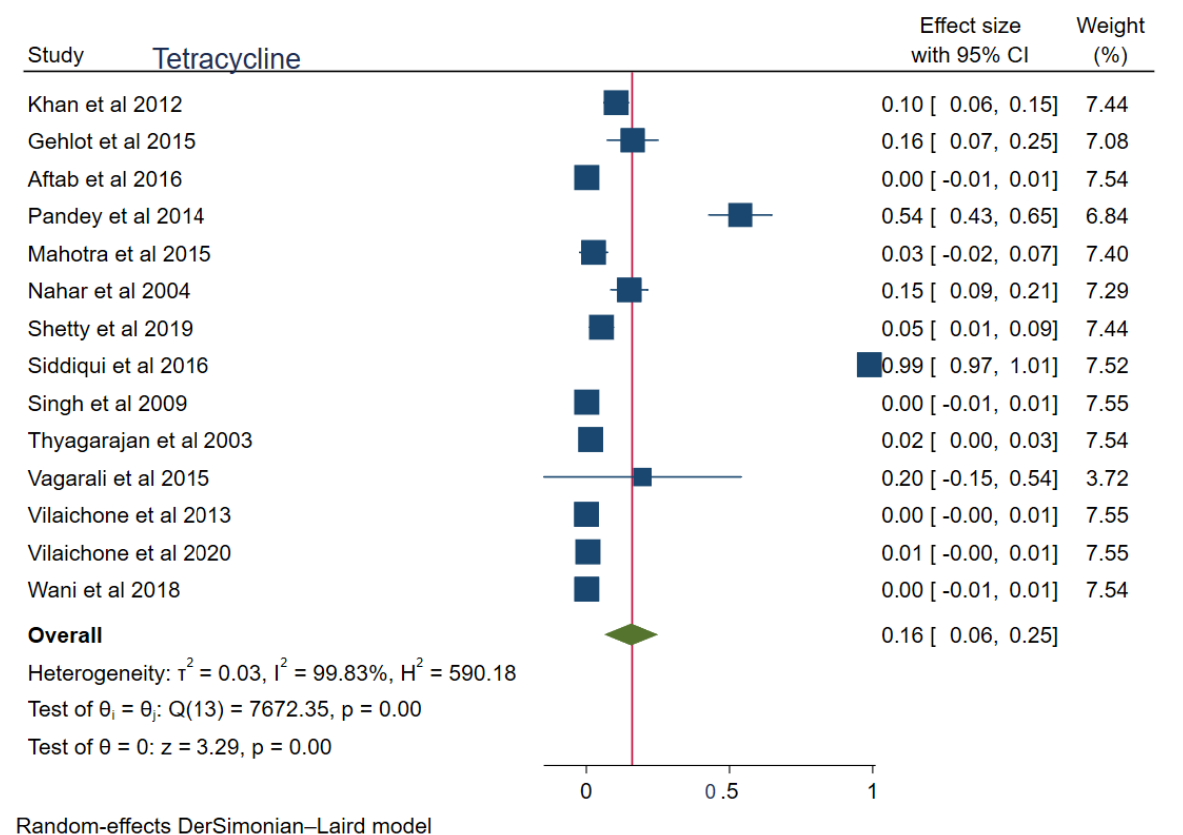
Figure 5. Forest Plot Showing Tetracycline Resistance. (Reference studies: [14,15,21,22,24,25,27,30,34–39]).